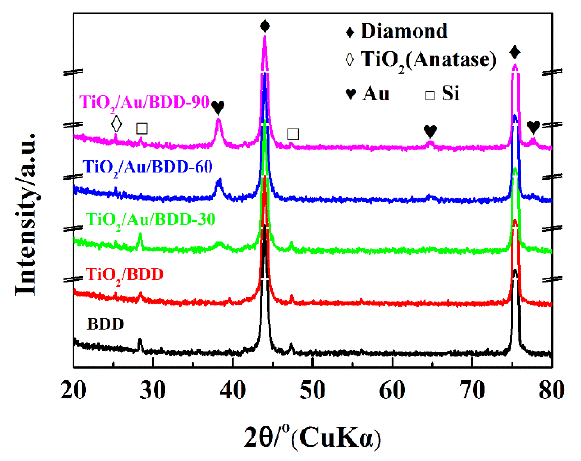
Figure 2. XRD patterns of the BDD, TiO 2 /BDD, TiO 2 /Au/BDD electrodes.